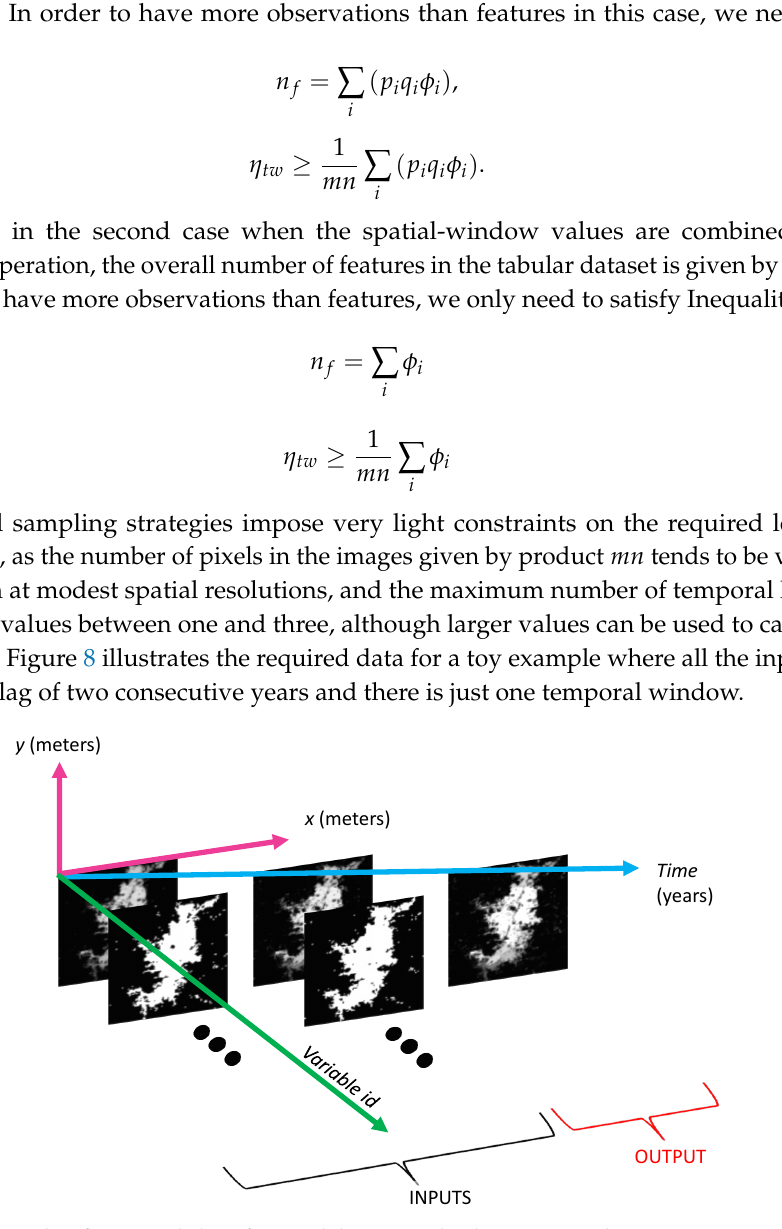
Figure 8. Example of required data for modeling a multiple input single output spatio-temporal dynamic system of a selected city, assuming a temporal lag of two years for the input variables, and selecting the population distribution as the output variable. These data can be seen as part of a single temporal window of a larger